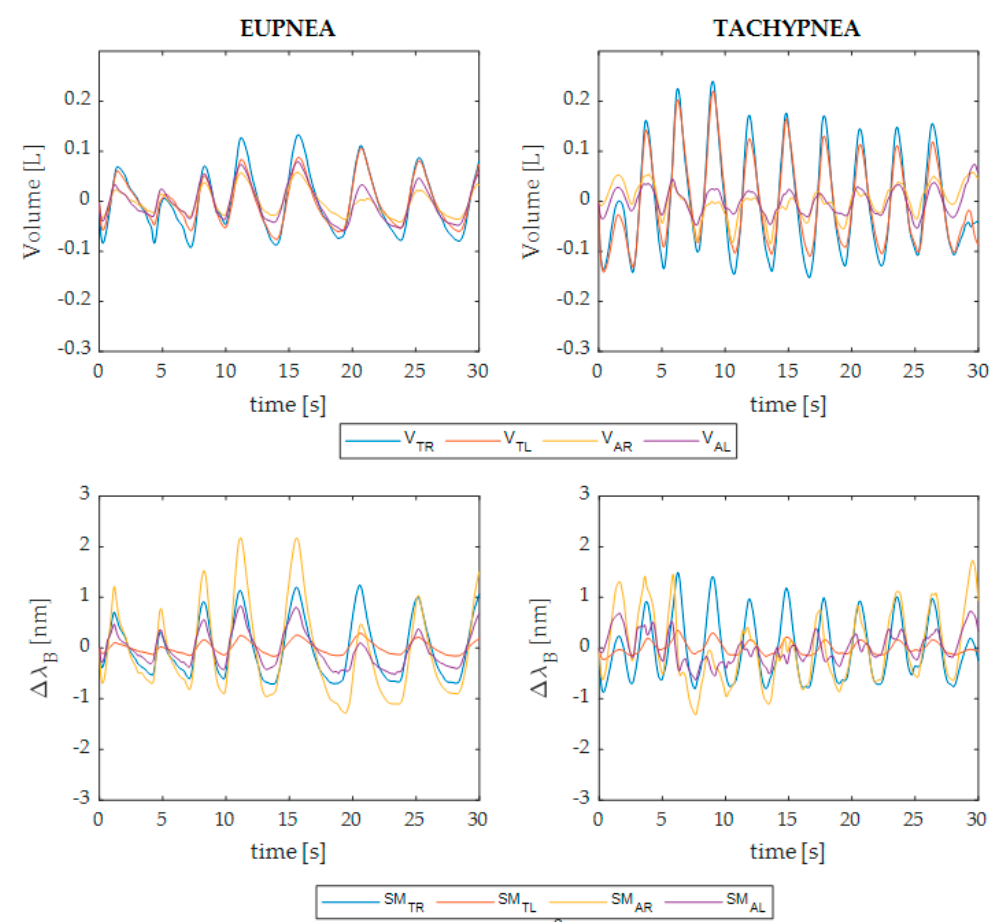
Figure 2. Example of the respiratory signals retrieved by the MoCap (upper graphs) and wearable system (bottom graphs) during 30 s of eupnea and tachypnea trials (left and right columns, respec- tively) performed by a patient. In blue, orange, yellow, and purple are shown the signals related to the TR, TL, AR, and AL compartments, respectively (i.e., V TR , V TL , V AR , and V AL for the MoCap